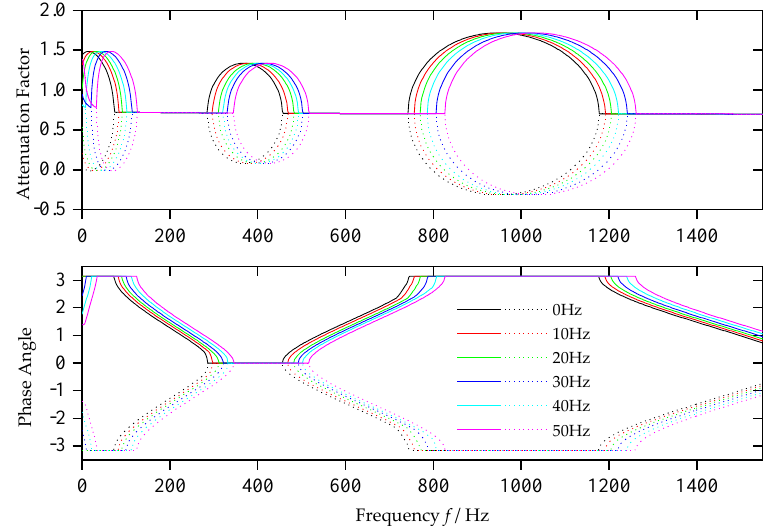
Figure 12. Numerical propagation constants derived from different rotating speeds.